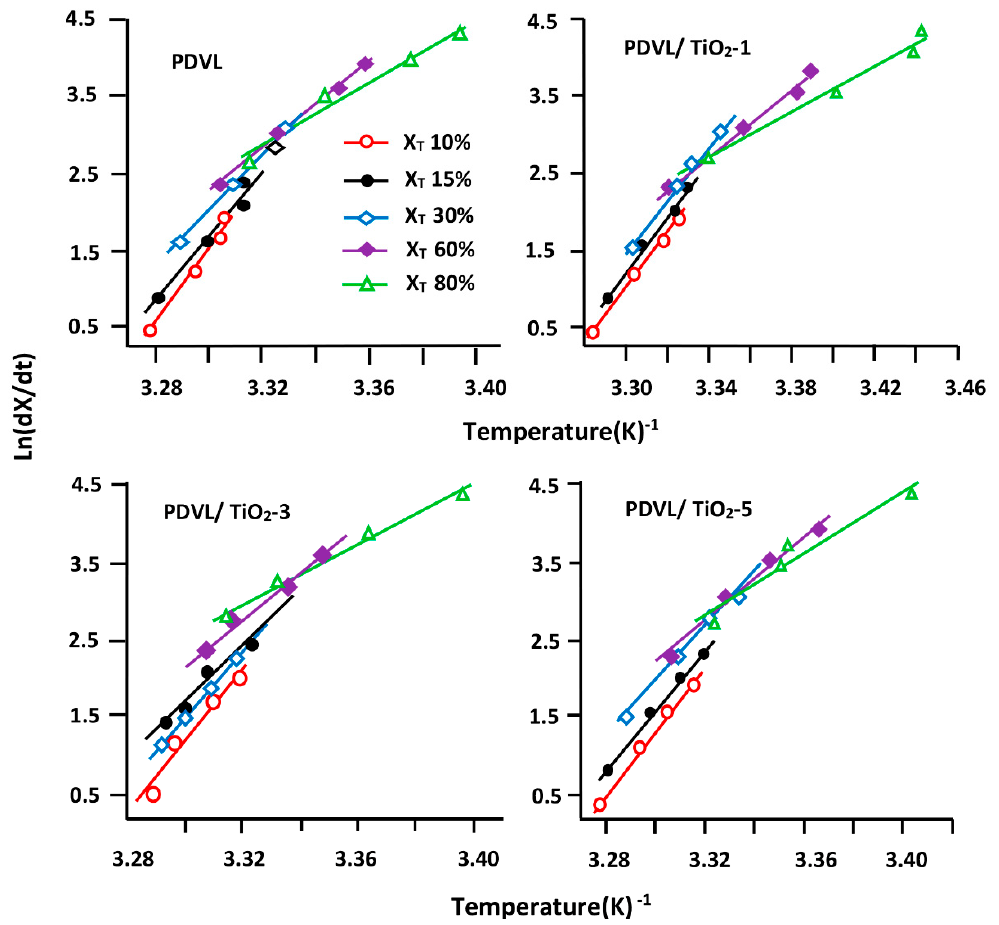
Figure 12. Variation of the instantaneous crystallization rate dX / dt versus the reverse of temperature for pure PDVL and PDVL/TiO 2 hybrid materials containing 1, 3, and 5 wt % of TiO 2 contents.